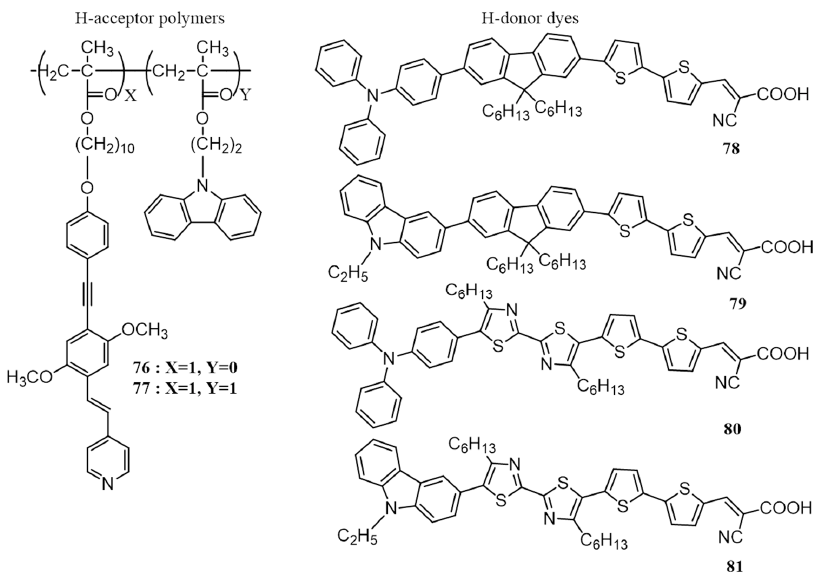
Figure 27. Chemical structures of the polymers ( 76 , 77 ) and low-bandgap molecules ( 78 – 81 ) synthesized by Lin et al.